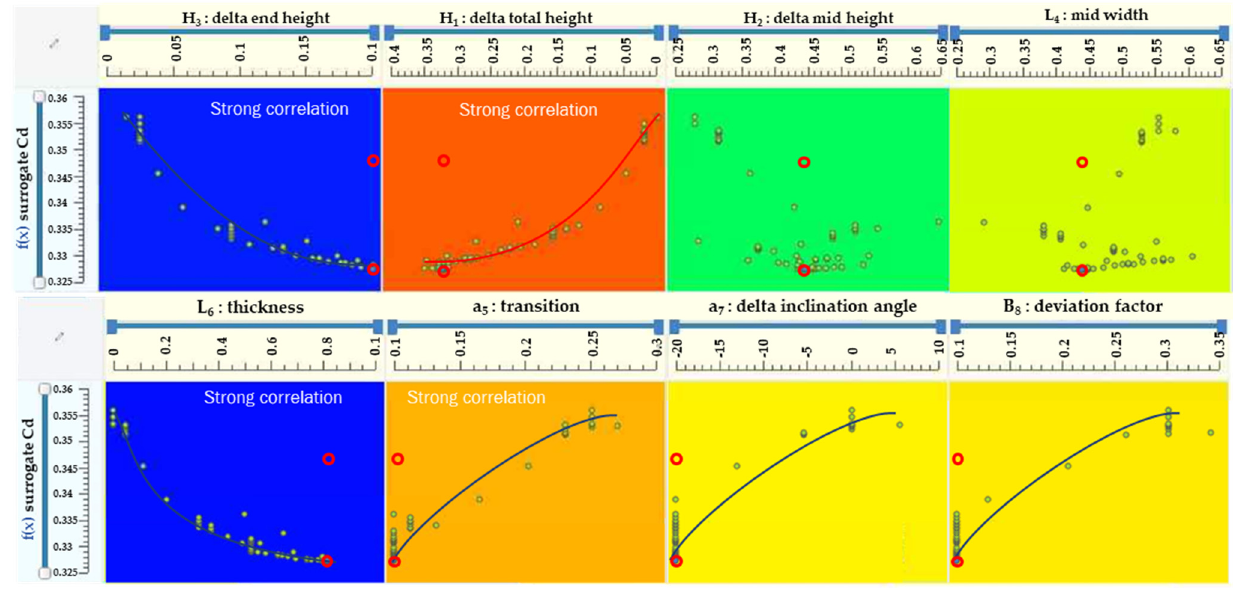
Figure 14. Cd objective curve versus design variables obtained with a gradient search on the Kriging model. The red circle at Cd = 0.348 corresponds to CFD validation with regard to the optimized predicted Cd value of 0.327.